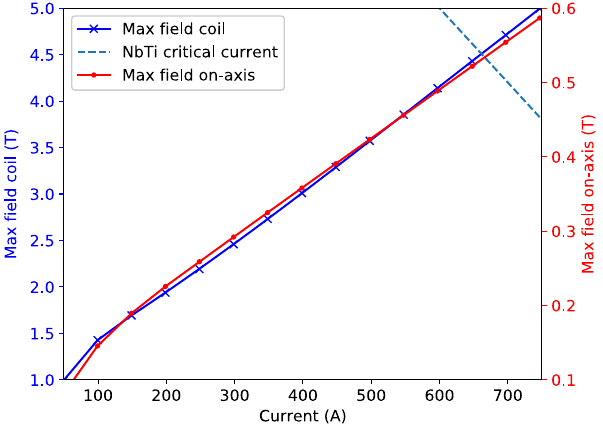
FIG. 14. Maximum field inside the NbTi coils and on-axis of the HSCU magnetic design. The dashed line represents the critical curve of the 0.7 mm NbTi from Supercon at 4.2 K. The expected operating point from the model is 475 A.